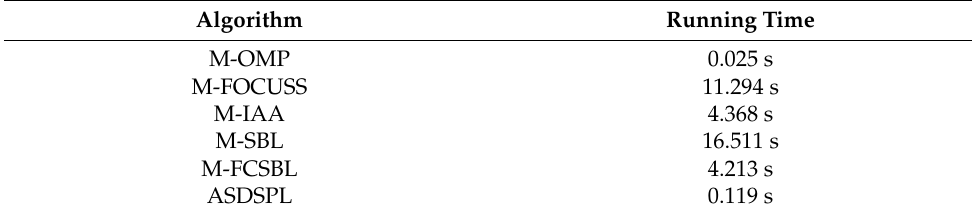
Table 3. Average running time comparison.